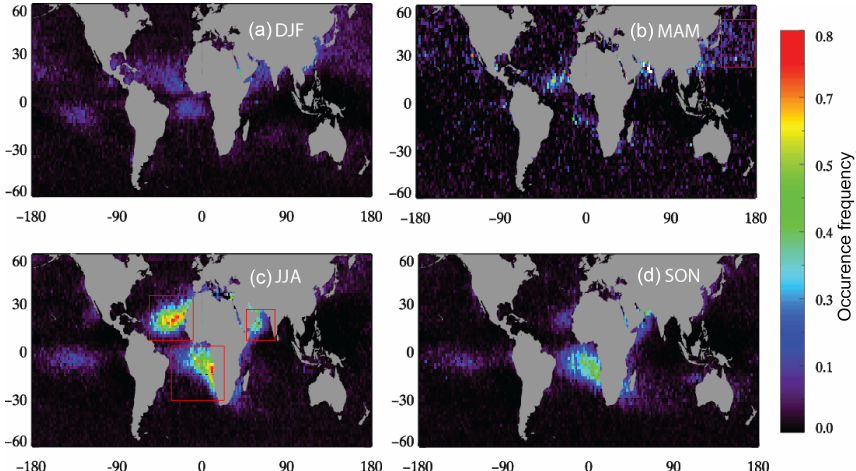
Figure 2. Multiyear seasonal mean occurrence frequency of ACA ( f ACA ) in (a) DJF, (b) MAM, (c) JJA and (d) SON derived from 8 years of daytime CALIOP observations. The red boxes indicate the four regions with high ACA occurrence frequency. See also Table 1 for the exact